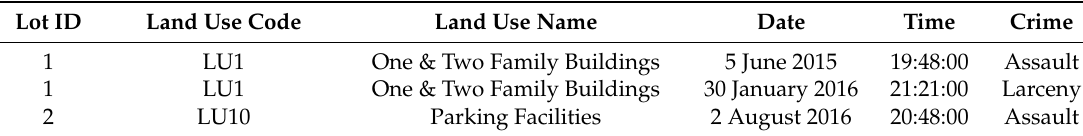
Table 3. Final geo-spatial dataset